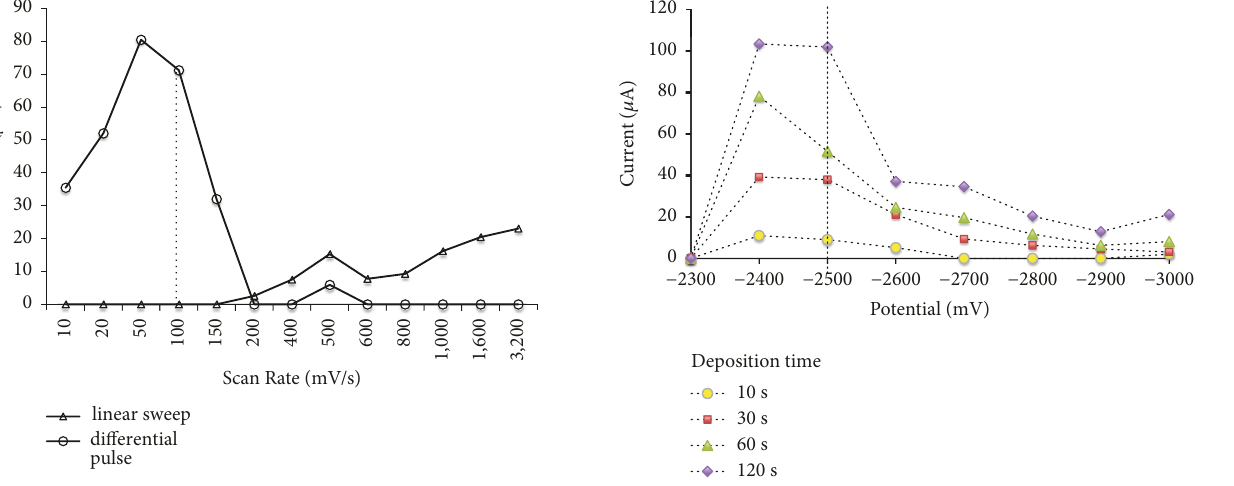
Figure 3: Response of Ba 10 𝜇 g/L to deposition times (10s – 120s) at various deposition potentials (-3000 mV – -2300mV). The vertical dotted line indicates the optimum deposition potential for